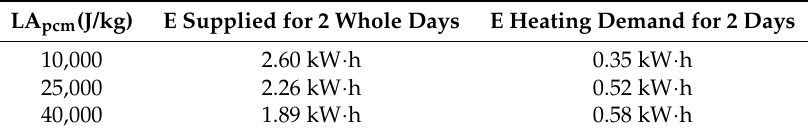
Table 3. Energy supplied by the solar Trombe wall and heating demand over 2